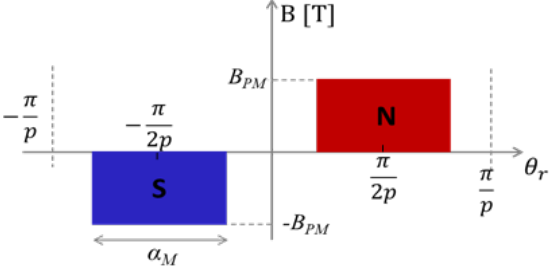
Figure 2. Permanent magnet (PM) demagnetization fault cases description: ( a ) Uniform demagnetization fault cases description; ( b ) Partial demagnetization fault cases description.